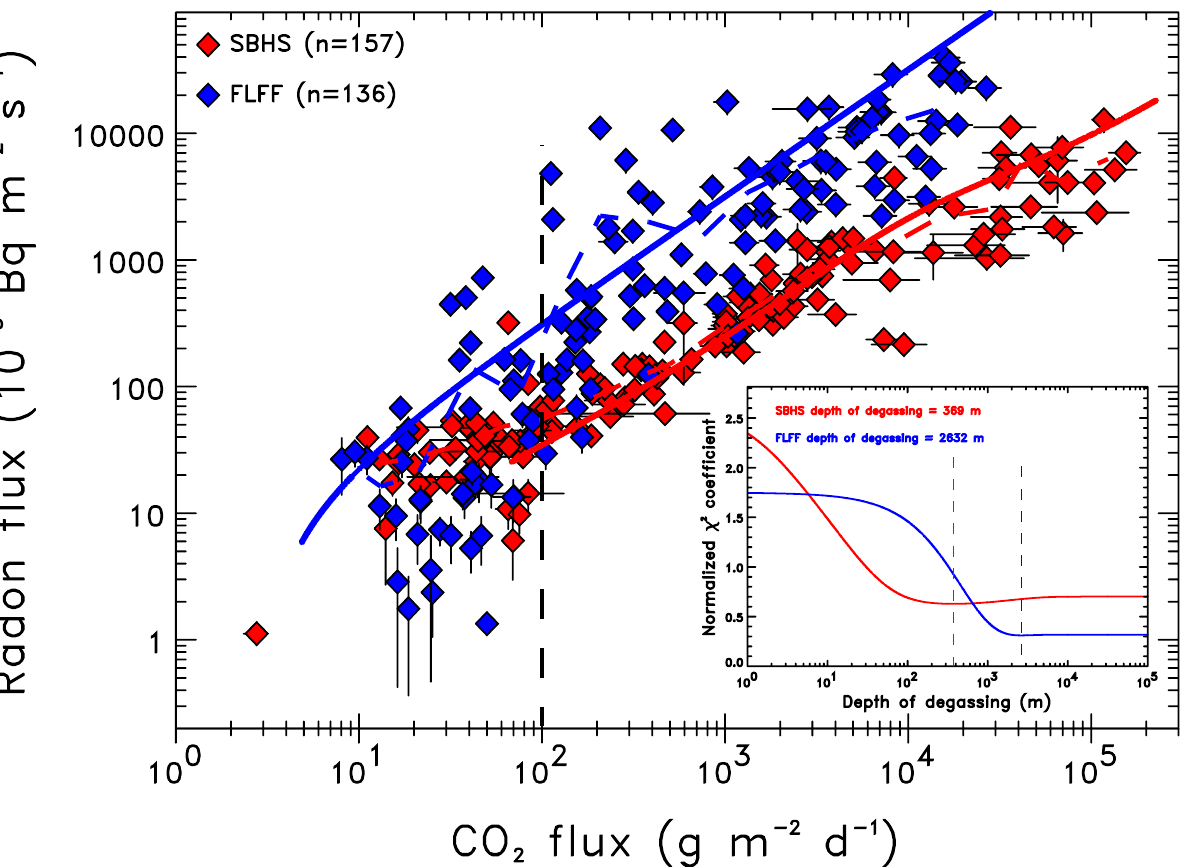
Figure 5. Radon ‒ CO 2 fluxes correlation for FLFF (in blue) and SBHS (in red). Only fluxes measured after the 2015 Gorkha earthquake are considered at SBHS. Diamond shows the data-set, dashed curve represents the average of the data, and solid curve is the calculation of the advective–diffusive radon transport model separately for each site using the depth of degassing constrained by an unbiased approach with 500 simulations (see “Methods” section). The bottom right inset represents the normalized χ 2 coefficient as a function of